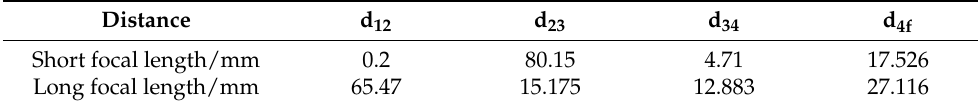
Table 5. Spacing between each group in the initial layout.